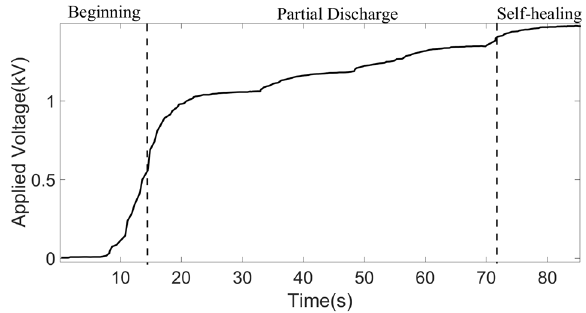
Figure 9. Typical process of applying voltage.